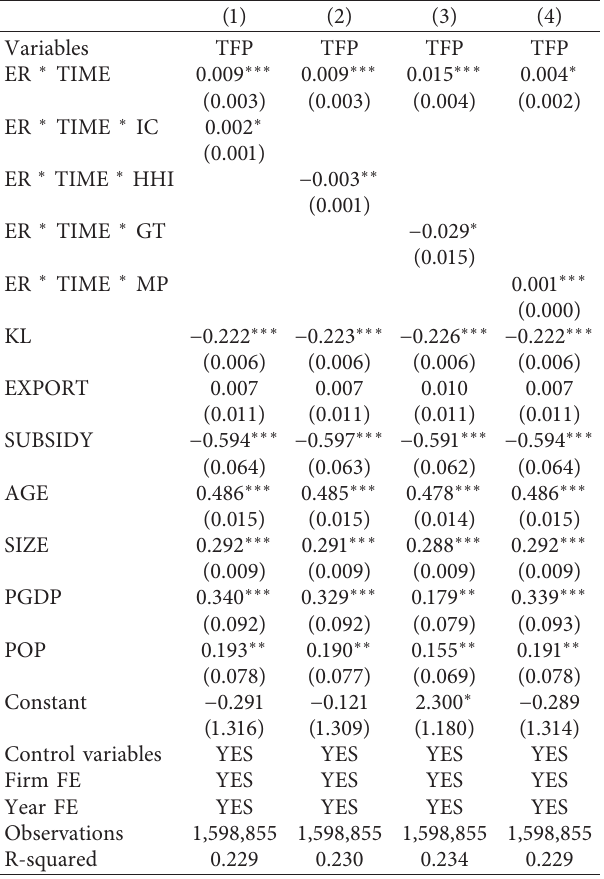
Table 4: Regression results containing different industry, gov- ernment, and market